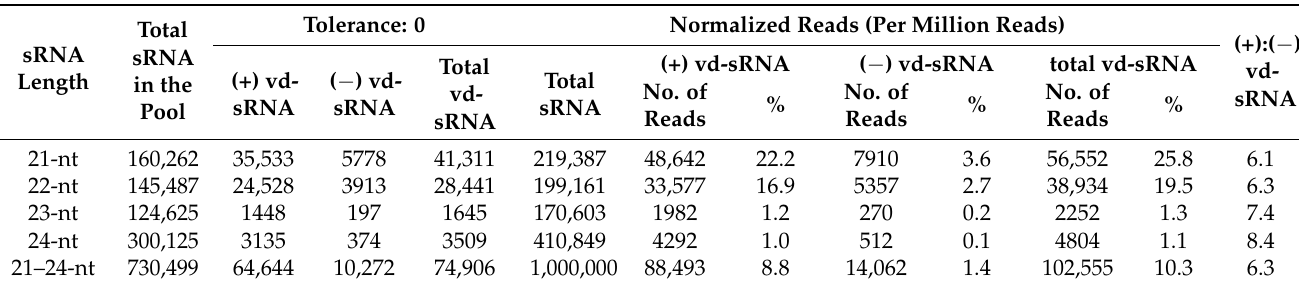
Table 4. Summary of the sRNAs identified by NGS from PSTVd-RG1-inoculated tomato plants cv. Rutgers at zero mismatch with the PSTVd-RG1